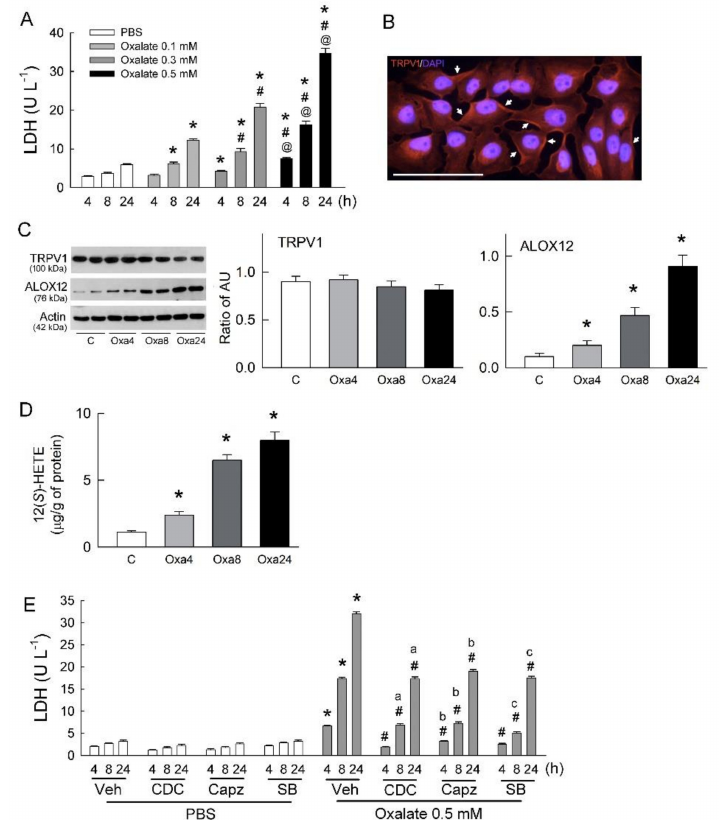
Figure 1. Transient receptor potential vanilloid 1 (TRPV1) inhibition abrogates oxalate-mediated tubular cell injury and increases in cytosolic Ca 2+ . ( A ) Release of lactate dehydrogenase (LDH) into culture medium, determined as a marker of cell injury after LLC-PK 1 cells treated with various doses of oxalate for 4, 8, and 24 h (n = 6 for each dose and time point). * p < 0.05 vs. PBS-treated group (control) at the same time-point; # p < 0.05 vs. oxalate 0.1 mM group at the same time-point; @ p < 0.05 vs. oxalate 0.3 mM group at the same time-point. One-way ANOVA was applied for statistical comparison. ( B ) Representative image showing presence of TRPV1 (in red, indicated by arrows) in cells. Cell nuclei were counterstained by 4’,6-diamidino-2-phenylindole (DAPI, blue). White bar indicates scale of 300 µ m. ( C ) Representative blots show TRPV1 and ALOX12 expression (n = 2 per group) in LLC-PK 1 cells using 20 µ g of total protein in each lane. Right bar graph shows densitometrically quantified results by ratio of TRPV1 or ALOX12 to actin (n = 6 per group). AU, arbitrary unit of band density; C, control cells treated with PBS for 24 h; Oxa4, Oxa8, and Oxa24 are indicated cells treated with 0.5 mM oxalate for 4, 8, and 24 h, respectively. * p < 0.05 vs. control (C) group analyzed by unpaired t -test. ( D ) Cellular content of 12( S )-HETE in groups. * p < 0.05 versus C group analyzed by unpaired t -test. ( E ) Release of LDH after cells treated with PBS or 0.5 mM oxalate or in combination with blockers of ALOX12 (CDC) or TRPV1 (Capz and SB) for 4, 8, and 24 h (n = 6 for each group and time point). Veh, 0.1% DMSO as vehicle